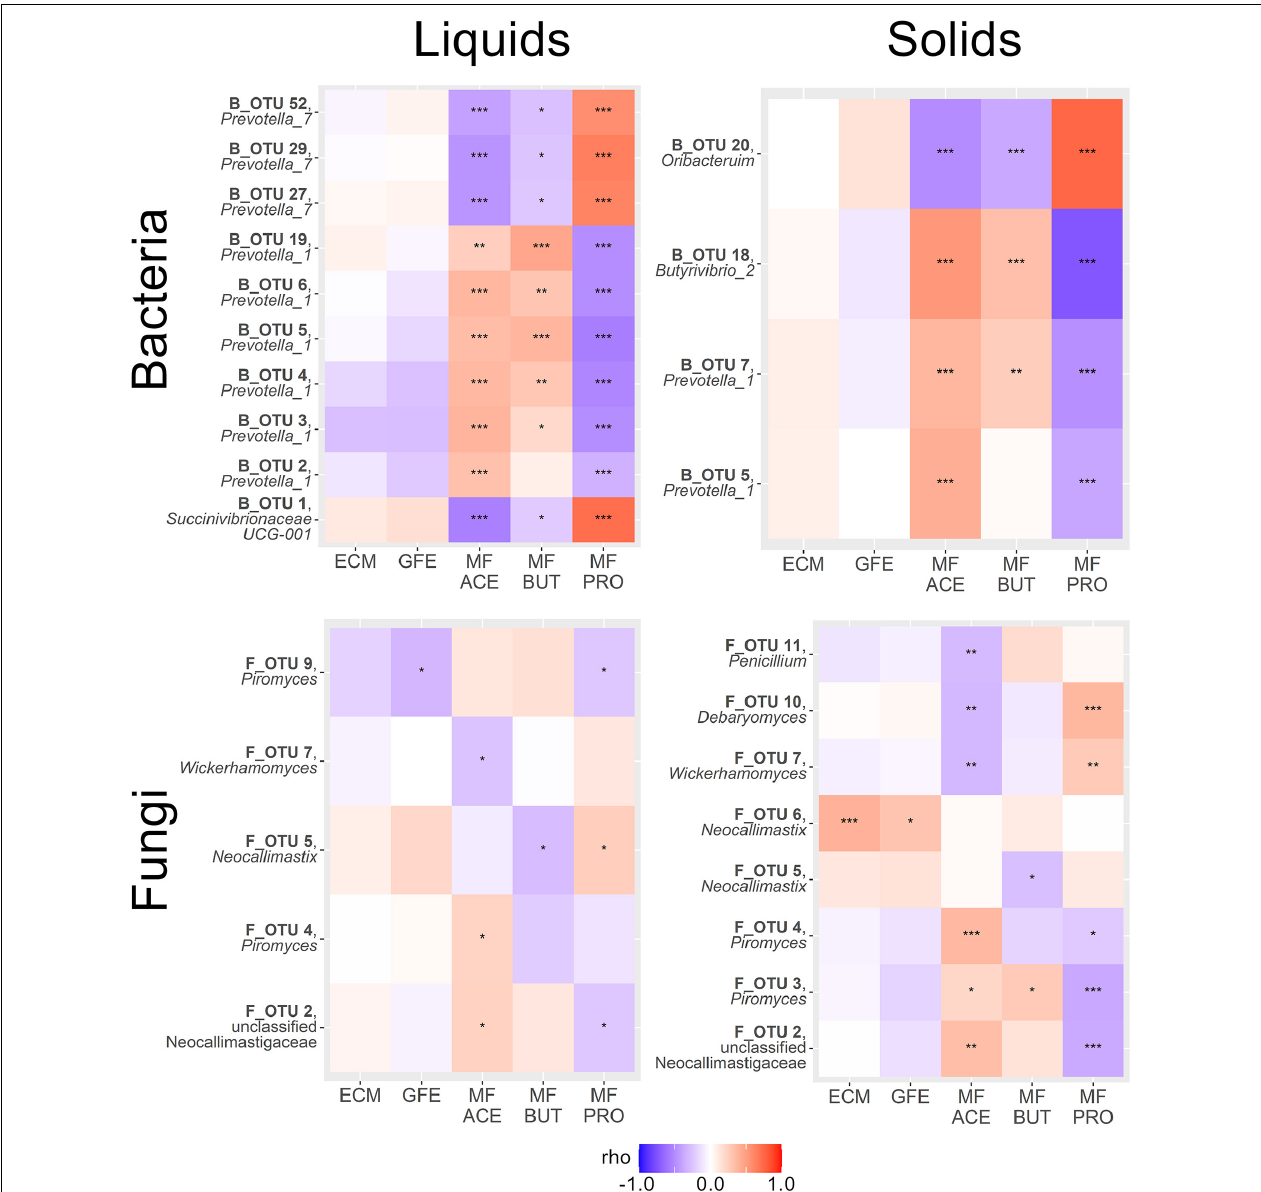
FIGURE 4 | Heatmaps summarizing correlations between SIMPER-implicated OTUs and phenotypic variables of interest within amplicon and sample type. Variables are energy corrected milk (ECM), gross feed efficiency (GFE), and molar fraction acetate (MF ACE), propionate (MF PRO) and butyrate (MF BUT). Genera displayed beneath OTU names. Color scale reflects strength and direction of correlation (Spearman’s ρ statistic), and asterisks within the heatmap indicate statistical significance (* P < 0.05, ** P < 0.01, *** P <